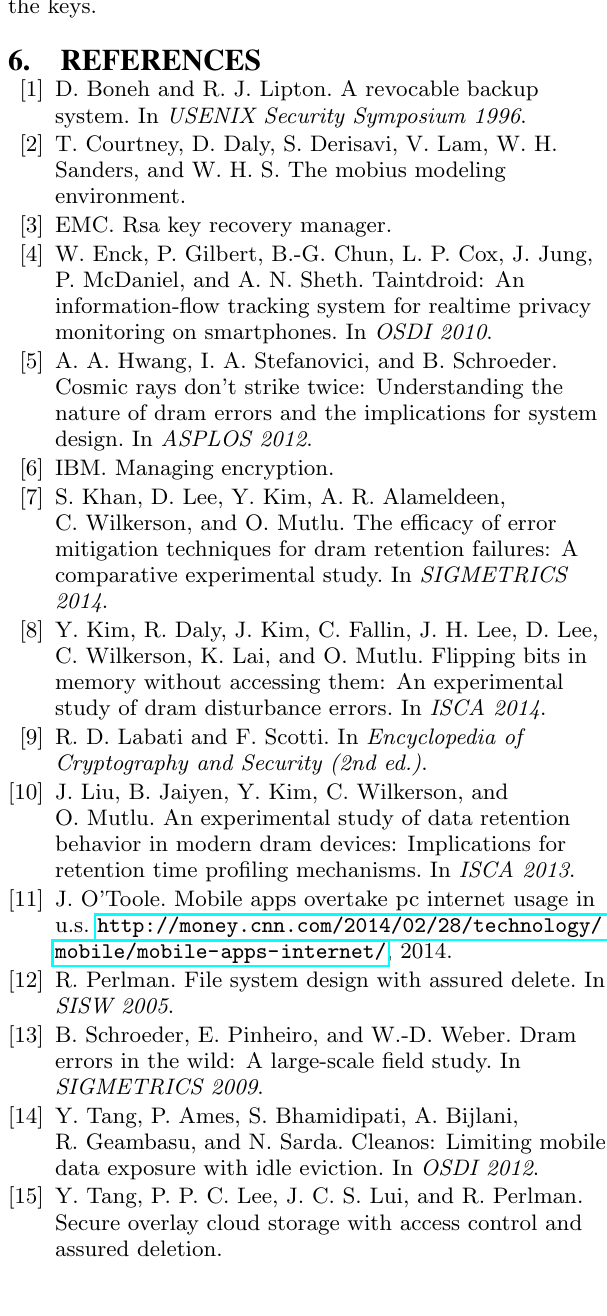
Figure 2: Failed cycles the